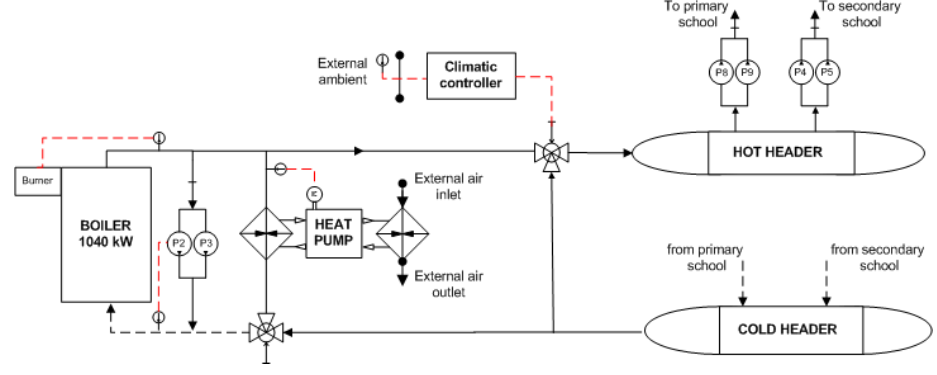
Figure 4. Hybrid thermal plant in parallel configuration.